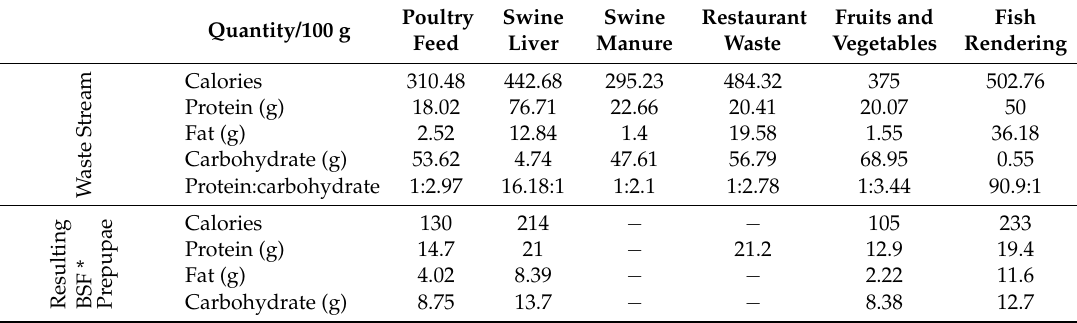
* BSF = black soldier